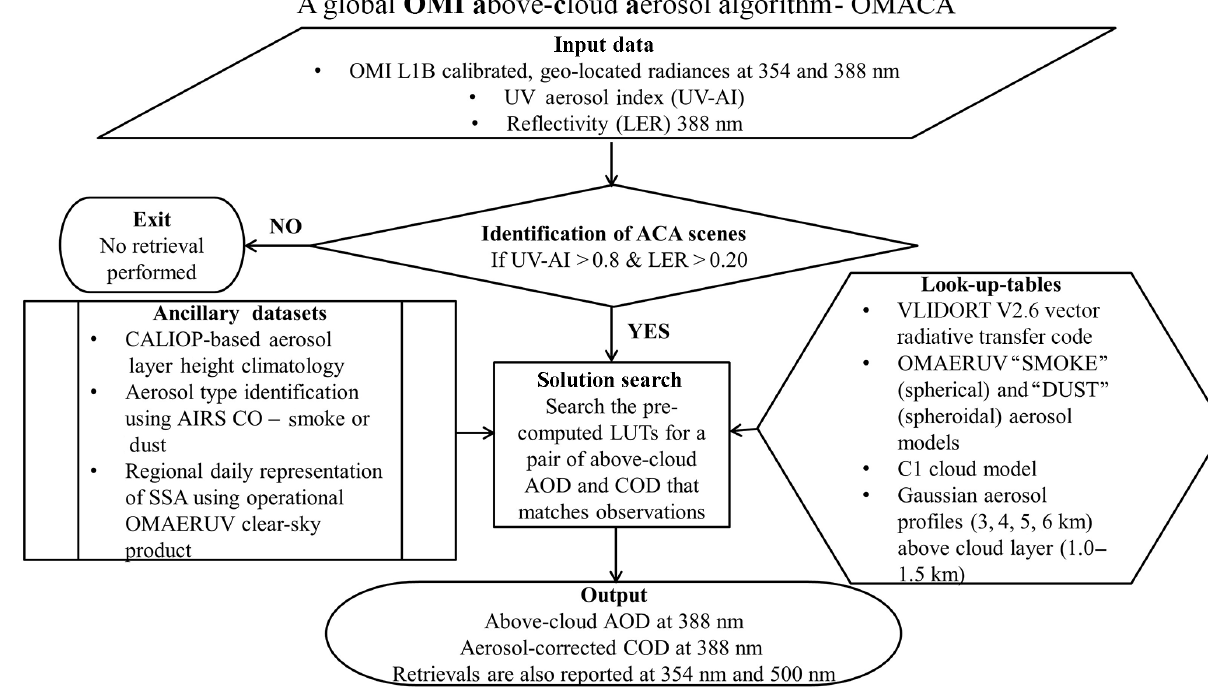
Figure 3. A general flowchart of the OMACA